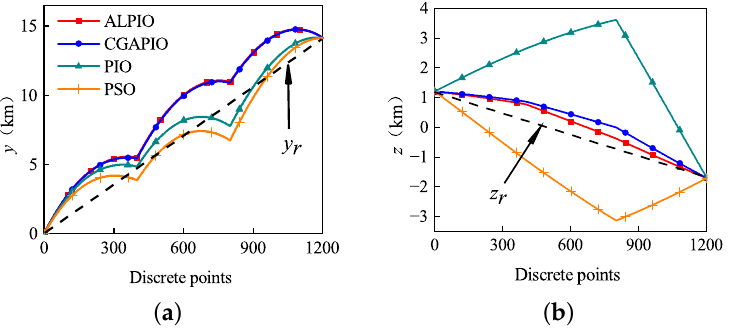
Figure 13. ( a ) Projection of the trajectory of Spacecraft 1 on the y r axis; ( b ) projection of the trajectory of Spacecraft 1 on the z r axis.